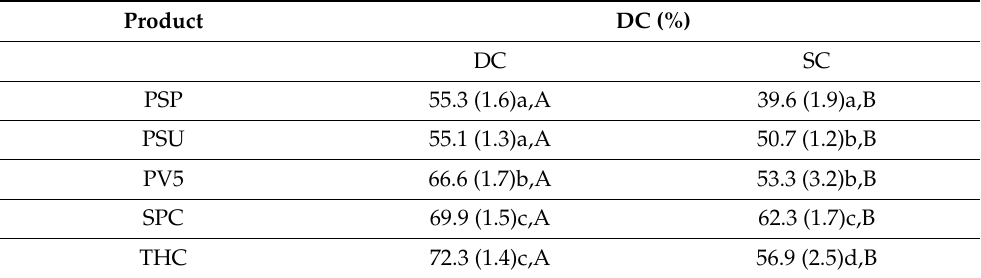
* Means and standard deviations (in parentheses). Same low-case letters show mean values with insignificant differences between the products within the same curing mode, whereas same upper-case letters show mean values with insignificant differences for the same product between the two curing modes ( p >